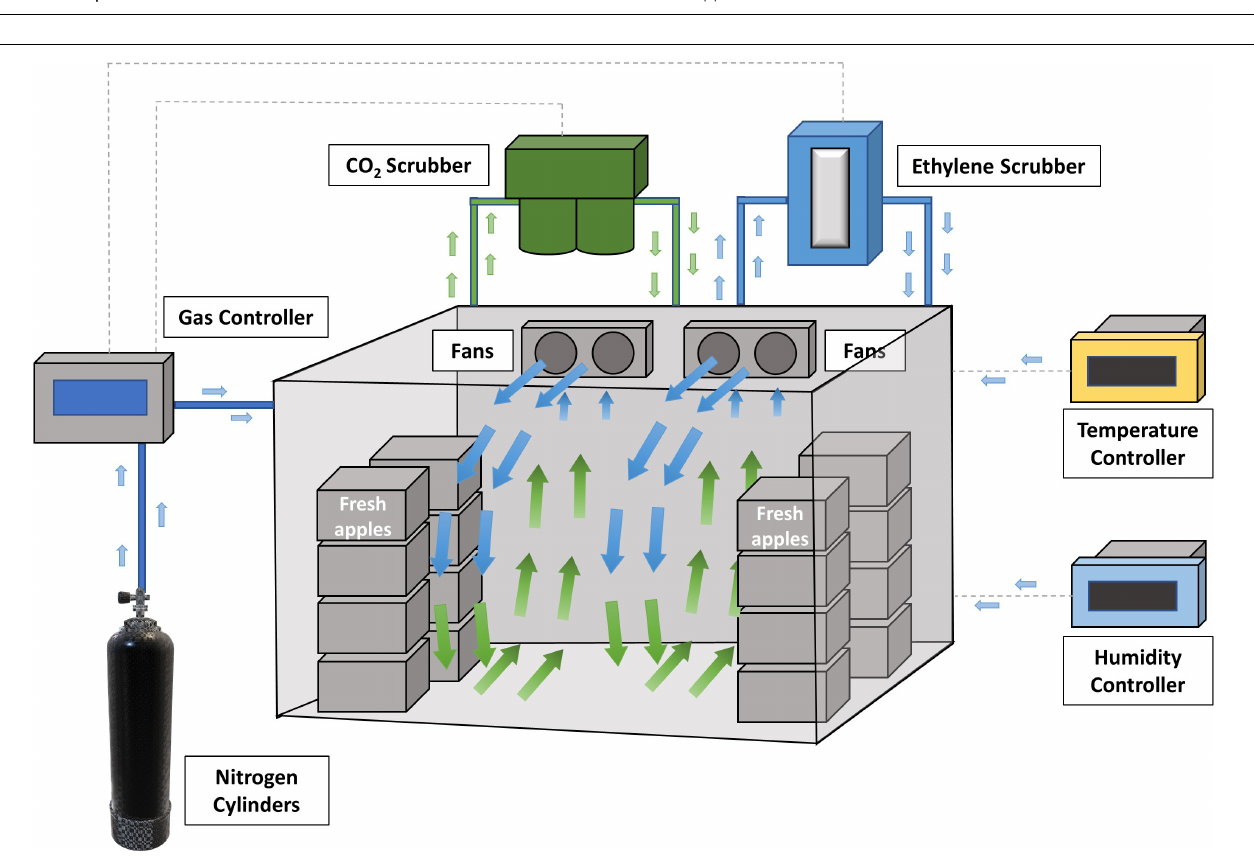
FIGURE 3 | Fresh apples are stored in a controlled atmosphere (CA) cold storage room (adopted from